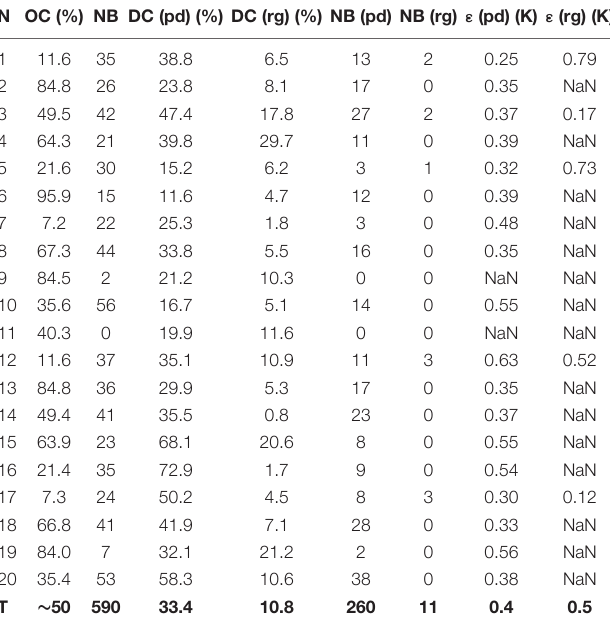
TABLE 1 | Statistical information of retrieved results for 20 granules from CC using two different methods of PDSST and RGSST5 for the month of October 2019.